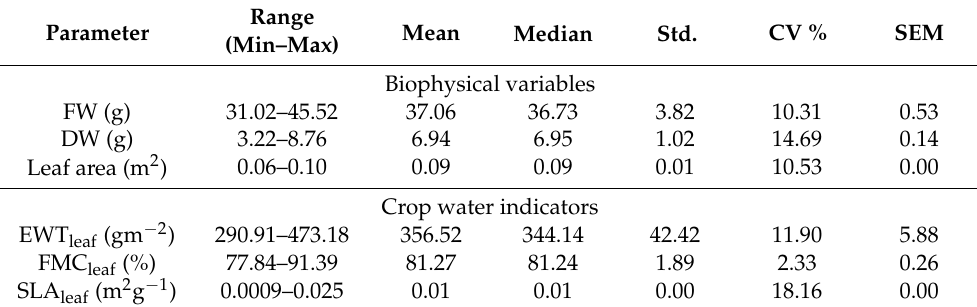
Table 4. Descriptive statistics of crop water indicators and biophysical